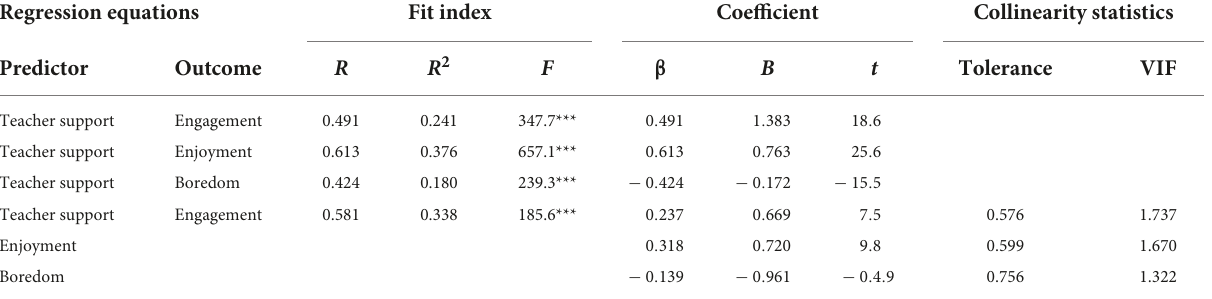
TABLE 4 Regression analysis results ( N = 1094).